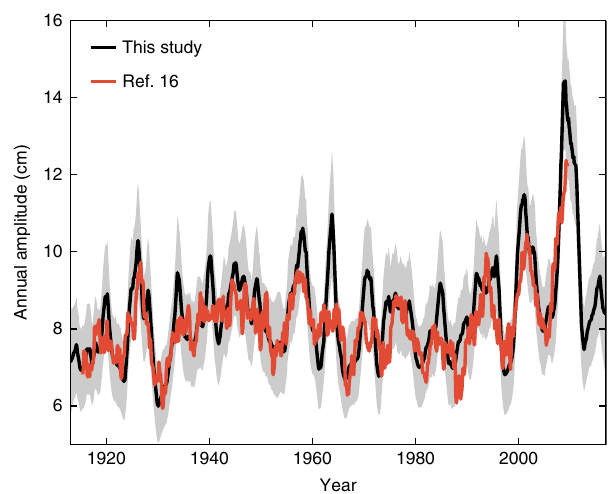
Fig. 3 SLAC amplitude at Key West. Comparison of the SLAC amplitude for the Key West tide gauge as estimated with a Bayesian state-space model (black) and by ref. 16 using the method of 5-year running windows (red). The gray-shaded area represents the 68% (1-sigma) credible interval for our estimate